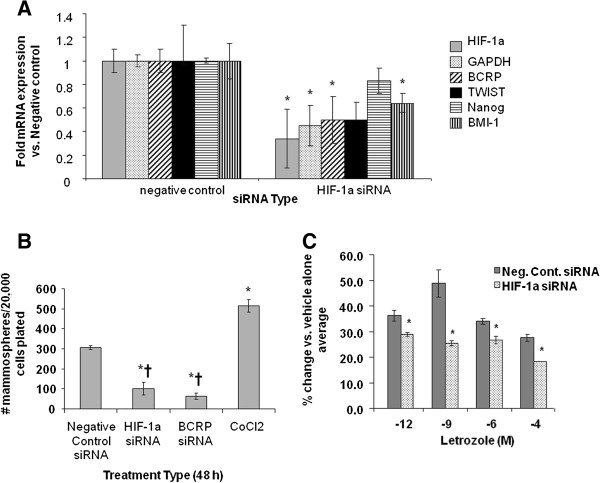
Effect of HIF-1α and/or BCRP siRNA on mammosphere formation and cell proliferation in LTLTCa cells. A) LTLTCa cells were treated with either negative control siRNA or HIF-1α siRNA for 48 hours. Total mRNA was extracted and HIF-1α, BCRP, GAPDH, Nanog, BMI-1 and TWIST mRNA, and 18S rRNA were analyzed by real-time RT-PCR. Real-time results are expressed as the fold-change in mRNA levels compared with negative control after normalization to 18S rRNA (mean ± SD, n = 6 independent cell samples/group; *versus vehicle; P = 0.0.132 HIF-1; P = 0.0058 GAPDH, P = 0.0377 BCRP, P = 0.0612 TWIST, P = 0.058 Nanog, P = 0.0214 BMI-1; two-sided t-test). B) LTLTCa cells were plated in passage media and then treated with negative control siRNA, HIF-1α siRNA, BCRP siRNA, or 100 μM CoCl2 for 48 hours. Cells were then collected and resuspended in mammosphere media on low-attachment cell culture wells. Results are expressed as number of mammospheres counted per 20,000 cells plated (mean ± SD, n = 6 independent cell samples/group; *versus negative control, P <0.001; † versus CoCl2, P < 0.001; overall P <0.0001, one-way ANOVA). BCRP siRNA confirmed to decrease BCRP expression (0.35- and 0.15-fold versus negative control, P <0.01, one-way ANOVA; data not shown). C) Viability of the cells was measured by the MTT assay after 48 hours treatment with negative control or HIF-1 alpha siRNA and subsequently 6 day treatment with increasing doses of letrozole. Results are expressed as percent of 0 μM letrozole (vehicle) (mean ± SD, n = 4 independent cell samples/group; *versus 0 μM letrozole, P <0.001; overall P <0.0001 one way ANOVA). ANOVA, analysis of variance; BCRP, breast cancer resistant protein; HIF-1α, hypoxia inducible factor 1 α subunit; MTT, 3-[4,5-dimethylthiazol-2-yl]-2,5 diphenyl tetrazolium bromide; n, number; SD, standard deviation.